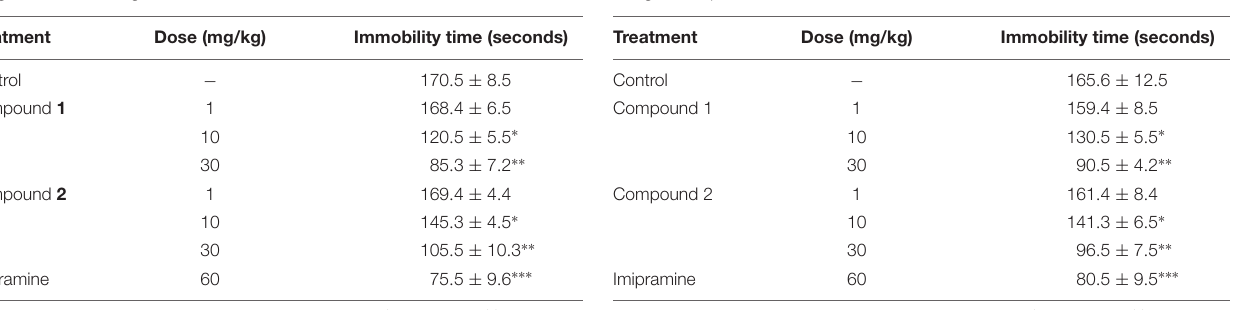
TABLE 3 | Effect of compounds 1 and 2 on immobility period (seconds) of mice using forced swimming